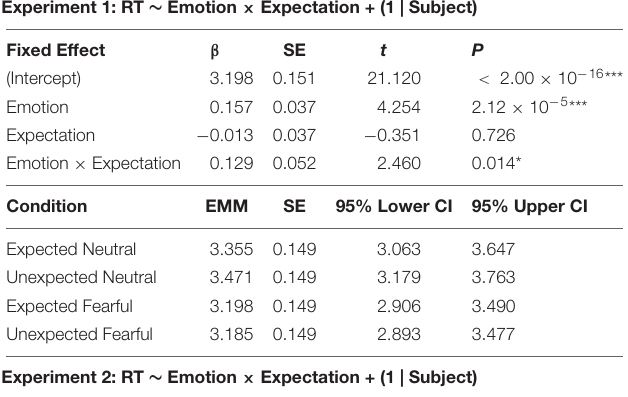
TABLE 1 | Response time models for Experiments 1 and